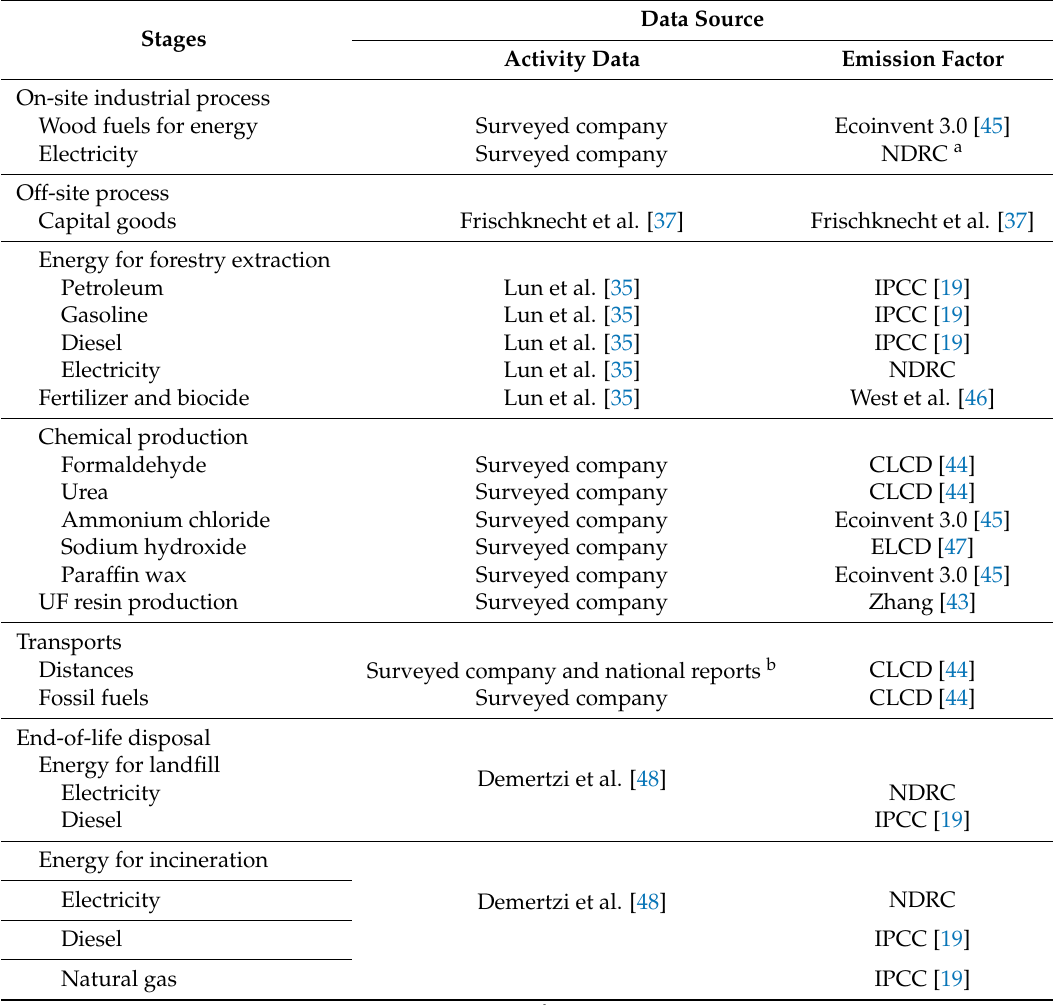
Table 3. Data sources for activity data and emission factors used to quantify the carbon footprint of medium-density fiberboard (MDF). UF: